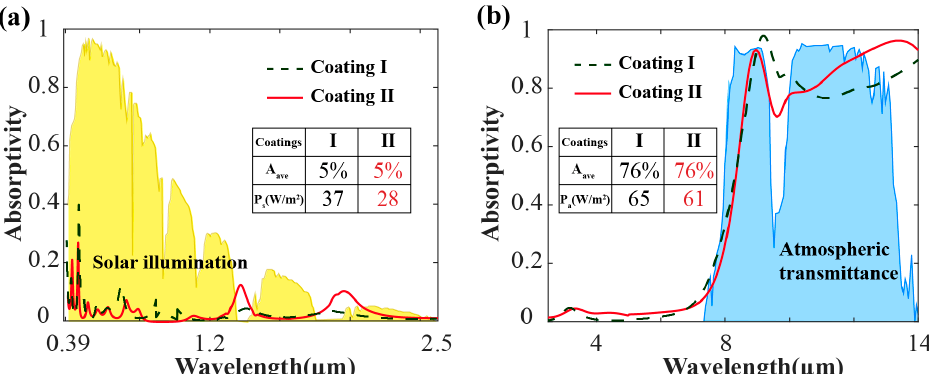
Figure 5. Absorption property of two coatings in the vis-infrared bands and mid-infrared bands. ( a ) Average absorptivity of coating I and coating II in 0.39–2.5 μ m is 5%. Absorbed solar irradiance (P s ) of coating I and coating II are 37 W/m 2 and 28 W/m 2 , respectively; ( b ) average absorptivity of coating I and coating II in 8–13 μ m is 76%. Absorbed atmospheric thermal radiation (P a ) of coating I and coating II are 65 W/m 2 and 61 W/m 2 , respectively. Table 2. Parameters of coating I and coating II.